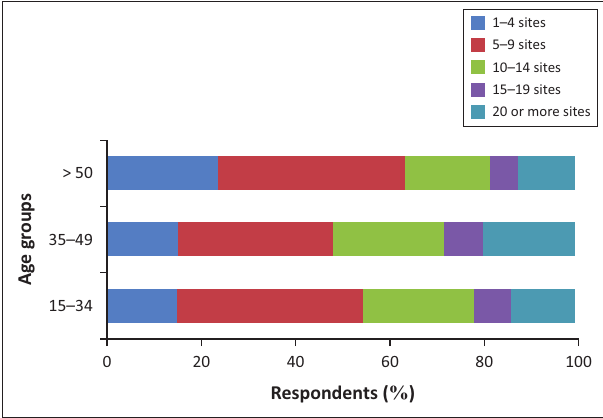
FIGURE 2: Weak password practices per age group. FIGURE 3: Age group versus number of sites requiring